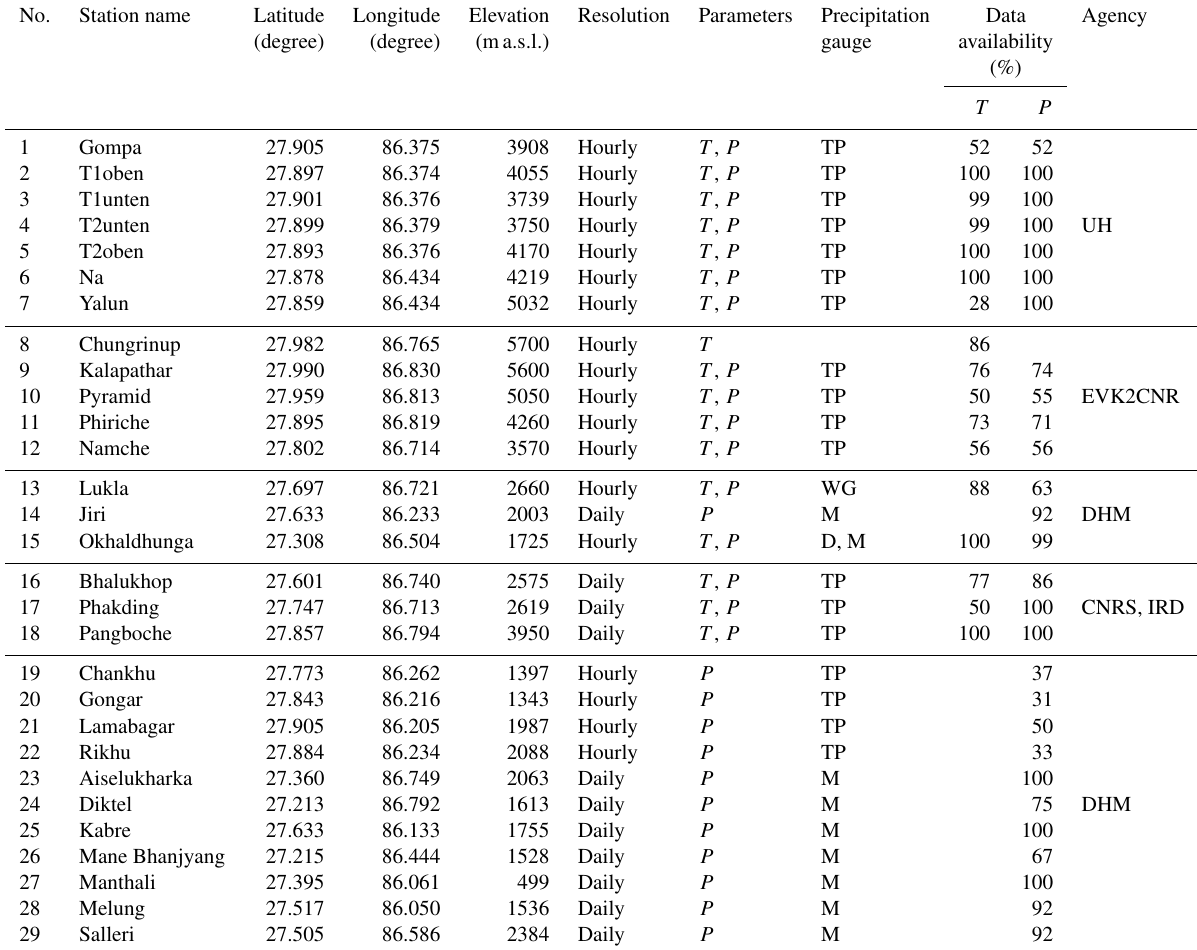
Table 2. Summary of meteorological stations. (TP: tipping bucket; WG: weighing gauge; M: manual; D: disdrometer; T : temperature; P : precipitation; UH: University of Hamburg; DHM: Department of Hydrology and Meteorology; CNRS, IRD: Université de